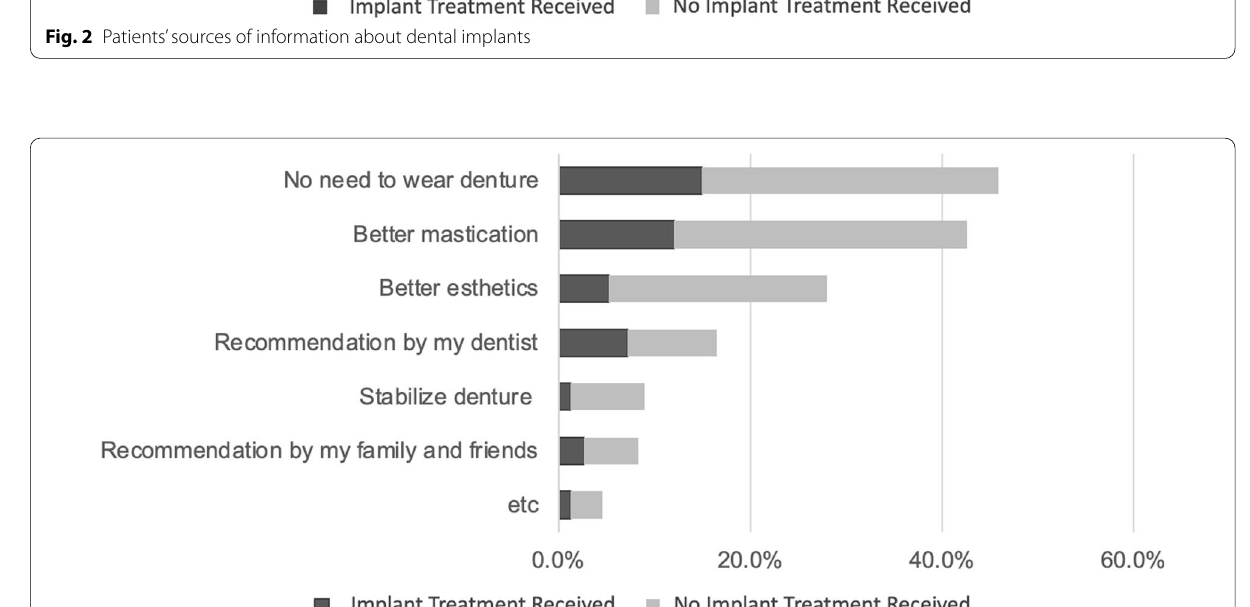
Fig. 3 Positive factors on decision to receive dental